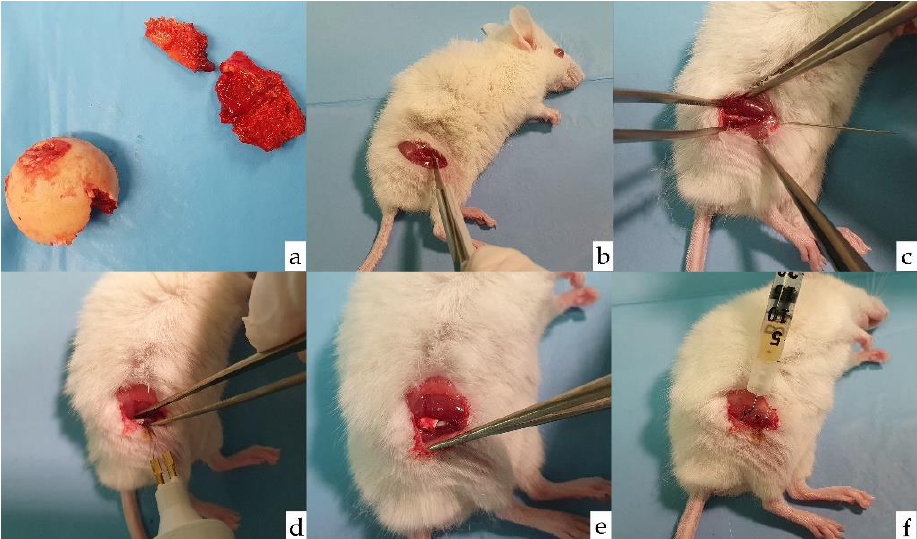
Figure 1. Surgical procedure. ( a ) Femoral head and neck of prosthetic replacement surgery that serves for extraction of bone cylinders and culture of MSCs. ( b ) Transverse osteotomy of the femur. ( c ) Retrograde 27 G needle insertion. ( d ) Cauterization of the fracture focus at periosteum level. ( e ) Addition of a collagen patch (Lyostypt ® , Braun-Aesculap, Tuttlingen, Germany to prevent cell migration. ( f ) Local injection of MSCs in Model B.